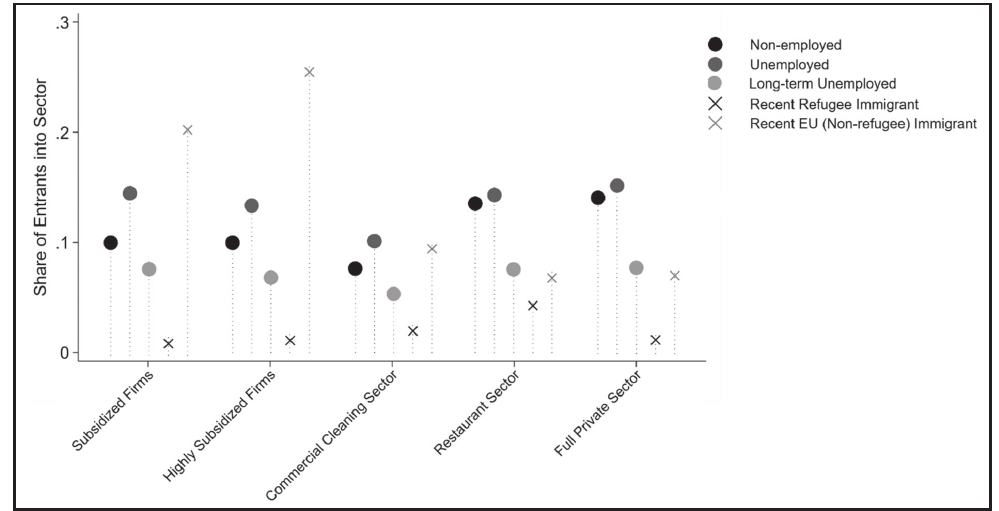
Profile of previous labor market statuses of sector